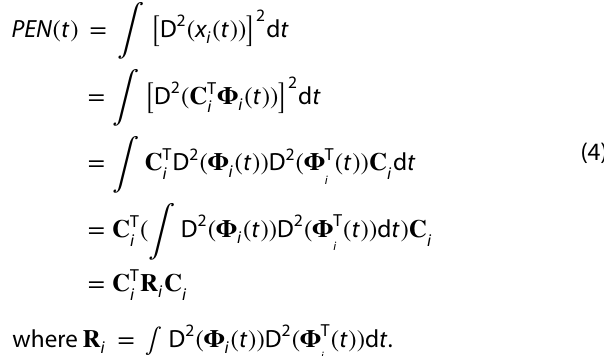
Fig. 2 Rolling speed and vibration data of the fifth stand